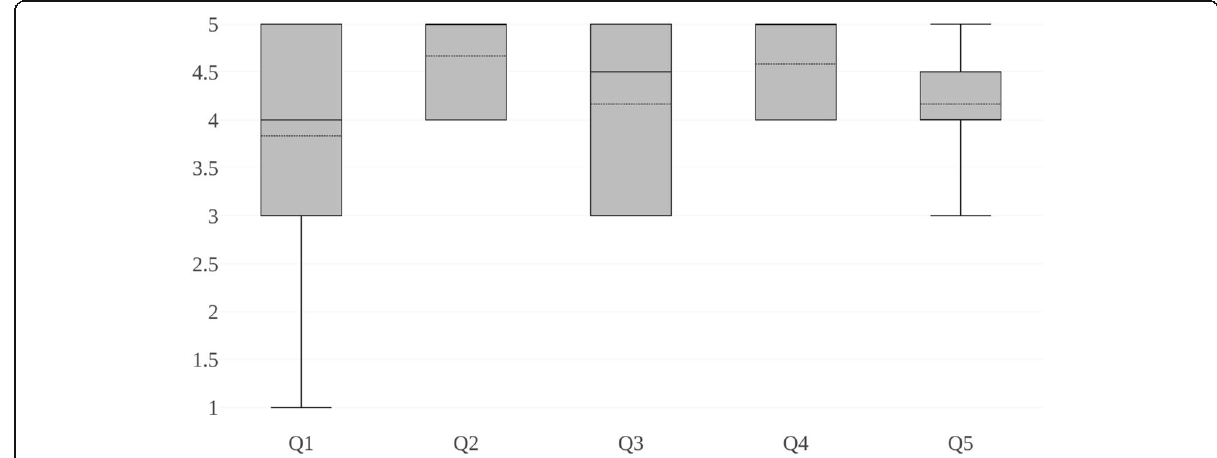
Fig. 6 Box plot reporting the KAVAS evaluation results. Solid lines mark the mean while dashed lines highlight the median